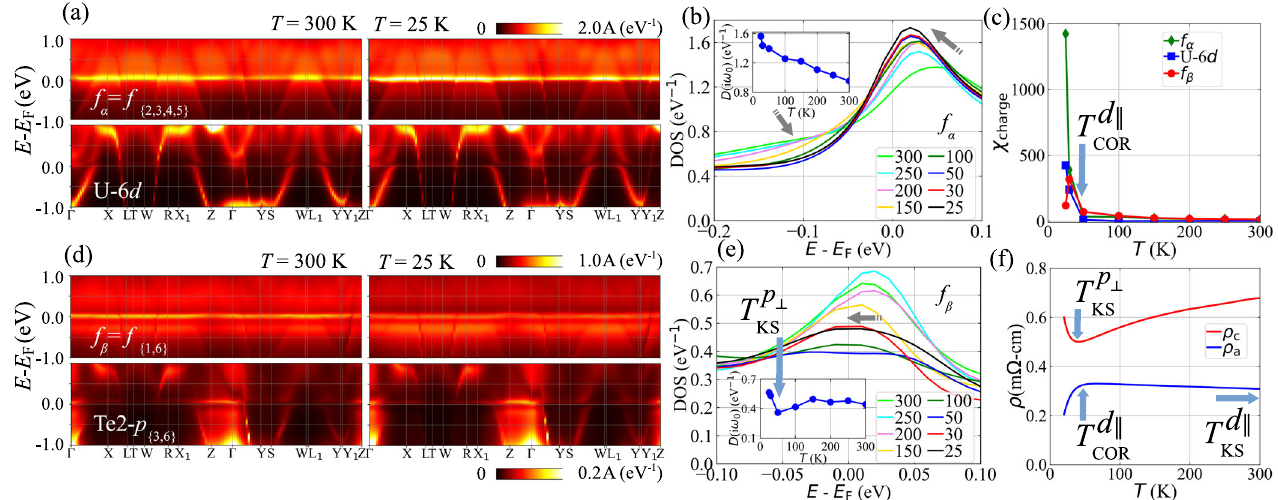
Fig. 3 Orbital resolved electronic structure of UTe 2 . a f α and U-6 d projected spectral functions at 300 (25) K in left (right) panel. b f α projected DOS. The gray arrows denote peaks evolution at temperature lowering. Inset shows f α DOS at the Fermi level. c Charge susceptibility of f α , U-6 d , and f β orbitals. d f β and Te2- p {3,6} projected spectral functions at 300 (25) K in left (right) panel. e f β projected DOS. The gray arrow denotes the peak center is shifted below the Fermi level. Inset shows DOS at the Fermi level. f Corresponding scales of Kondo scattering are denoted on measured resistivity along the a and c axes 21 . Note that the behavior of resistivity along the b axis (not shown here) is similar with ρ a . In ( b ) and ( e ), the temperature unit is